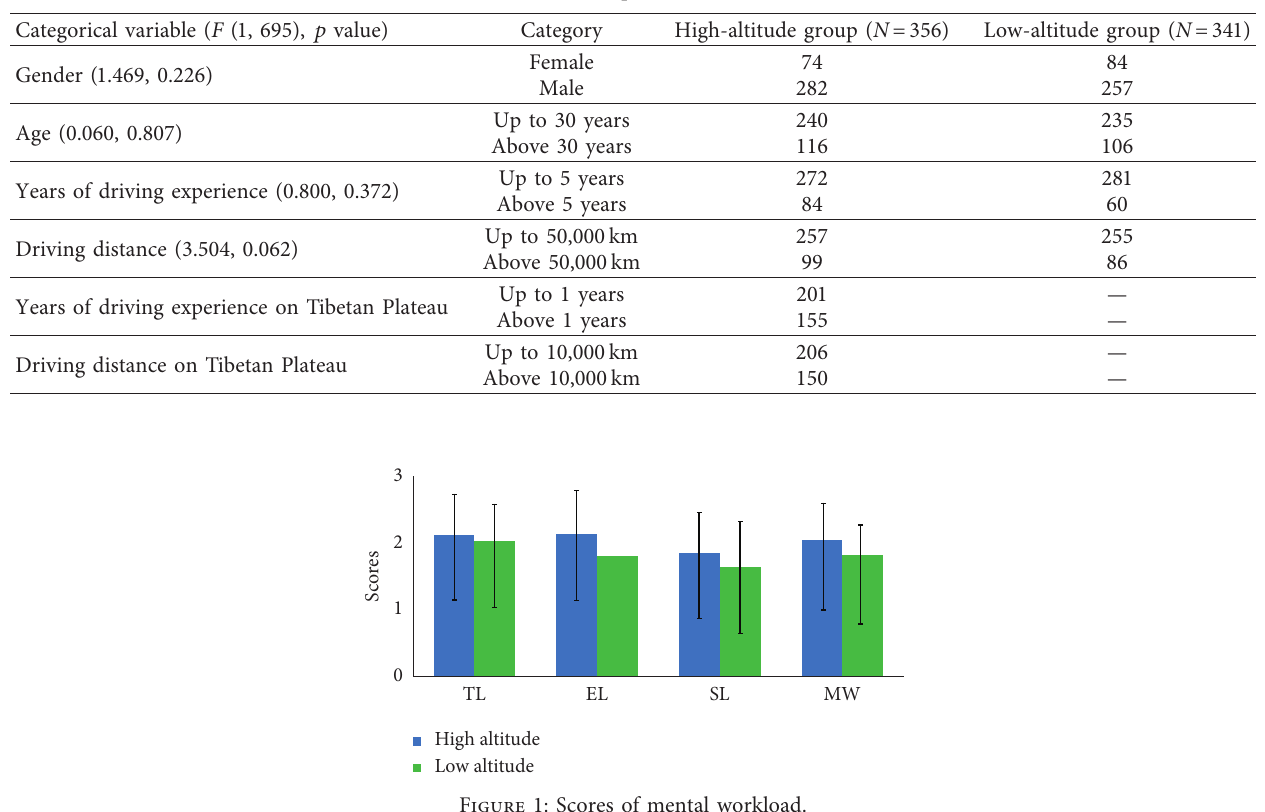
Table 1: Sample information.